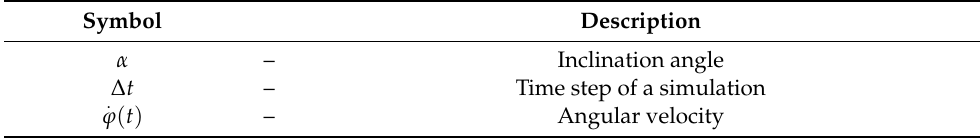
Table A1. List of markings used in the